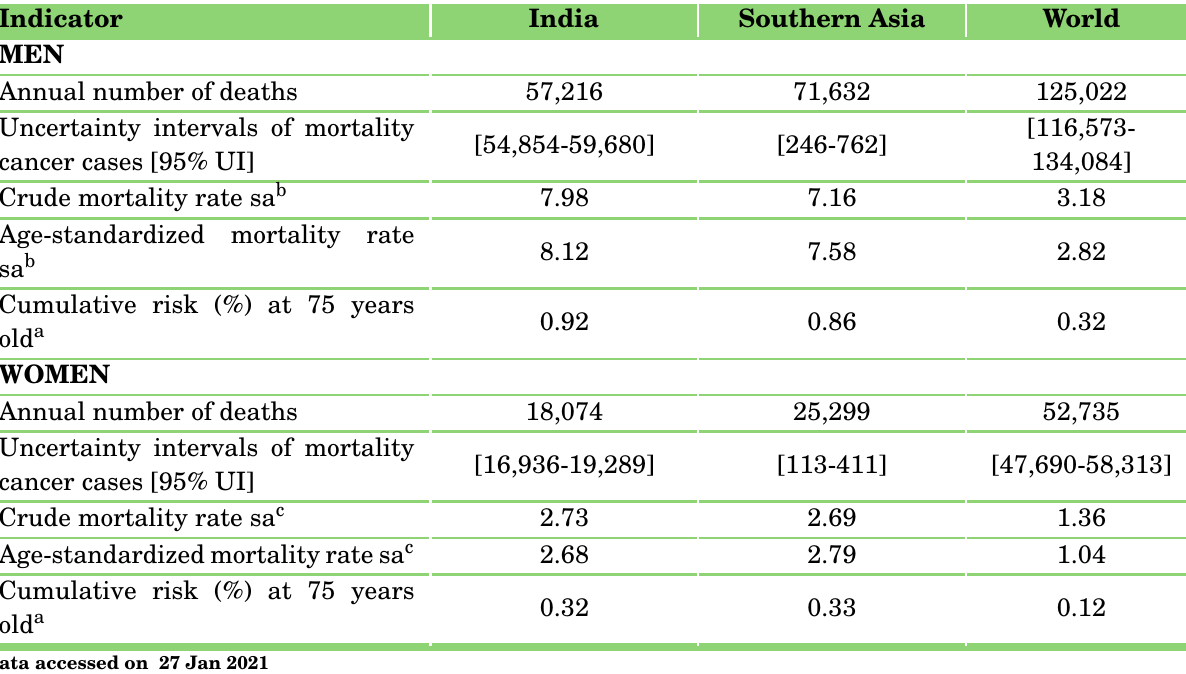
Table 18: Oral cavity cancer mortality in India (estimates for 2020)